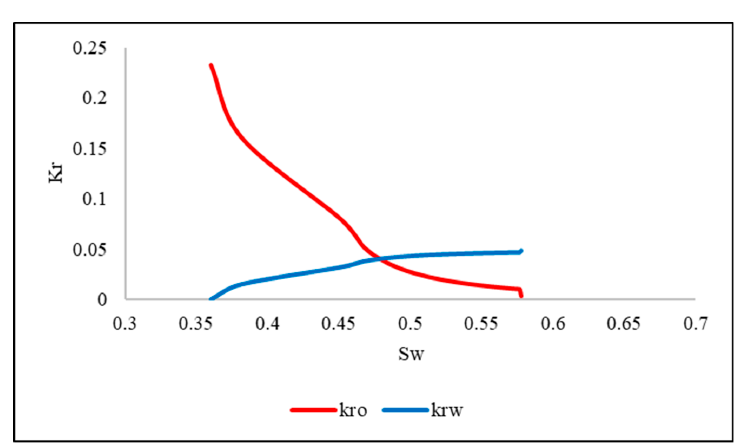
Figure 9. Clinton sandstone oil–water capillary pressure curve.